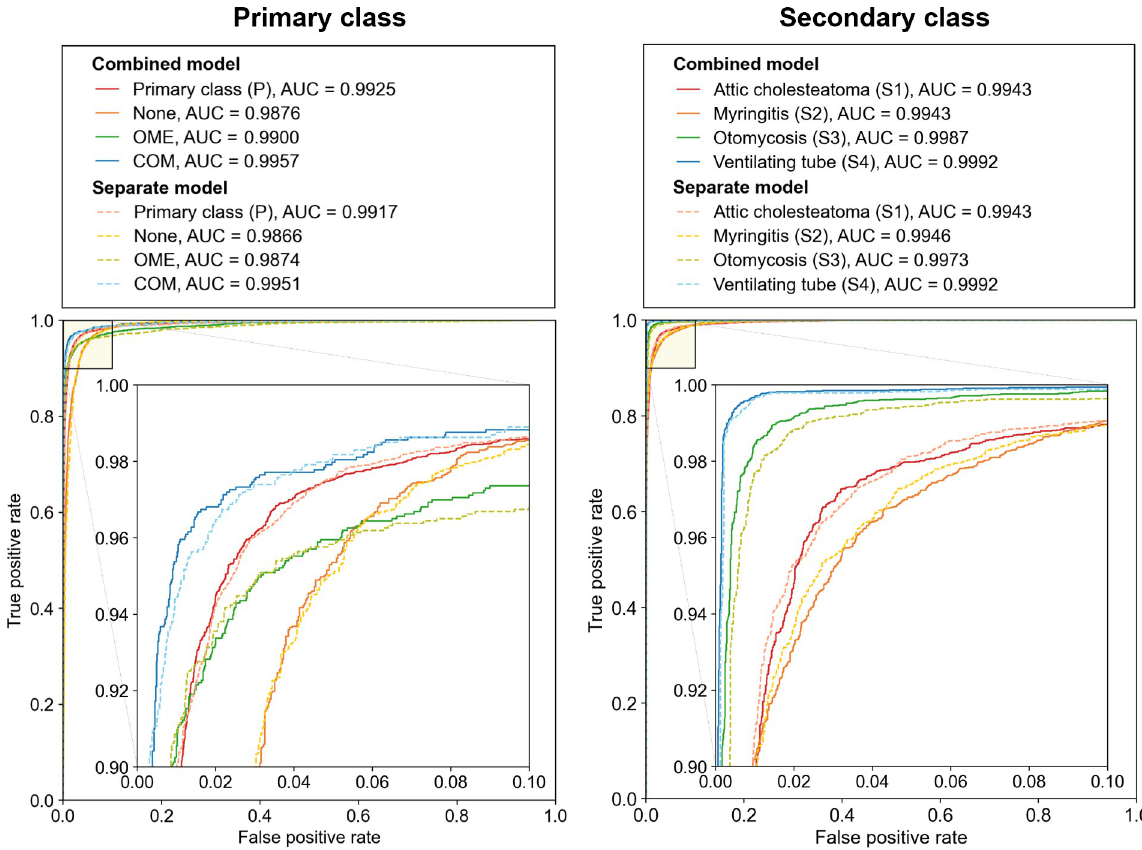
Fig 4. Receiver operating characteristics (ROC) curves and AUC values for primary and secondary classes. Micro-average was applied to evaluate the overall predictability of deep learning model for the primary class. AUC, area under the ROC curve; OME, otitis media with effusion; COM, chronic otitis